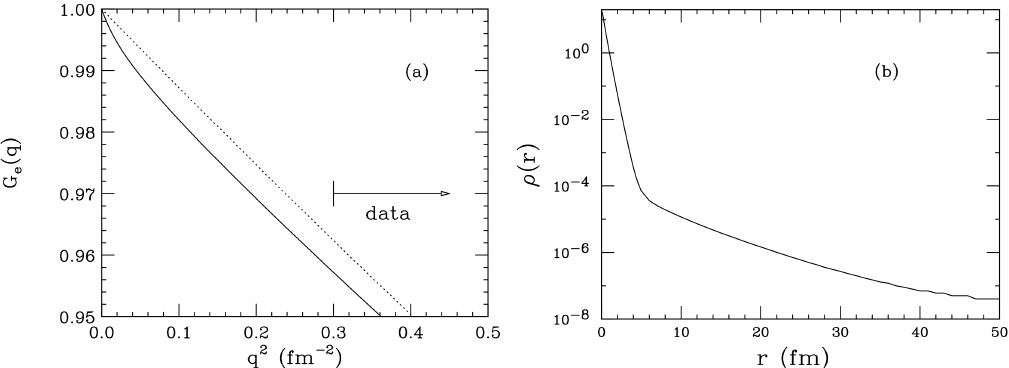
Figure 5. ( a ) [1/3] Padé fit (solid) together with the “standard” fit having R ∼ 0.88 fm. ( b ) Density corresponding to the Padé fit.